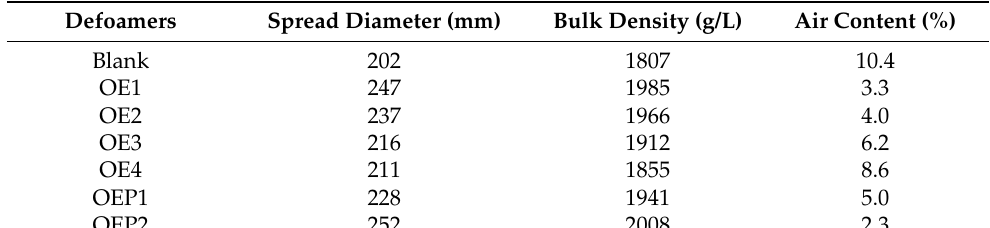
Table 4. The air content and spread diameters of the fresh mortar samples mixed with different defoamers.